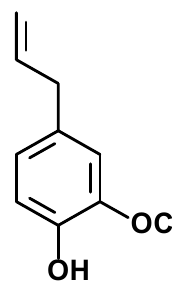
Figure 1. Chemical structure of eugenol.